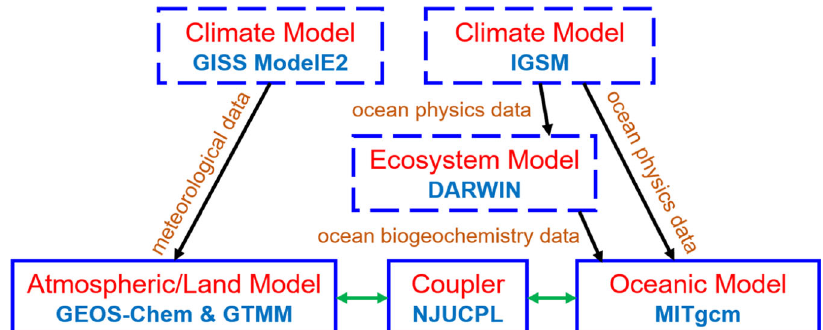
Fig. 6 The model framework used in this study. Blue boxes represent models while arrows indicate data fl ows. Models with dashed boxes are run by previous studies and we directly use their archived output, while those with solid lines are run in this study. Black arrows mean feeding of archived data from one model to another (i.e., models are run separately), while green arrows mean running two models simultaneously with online data